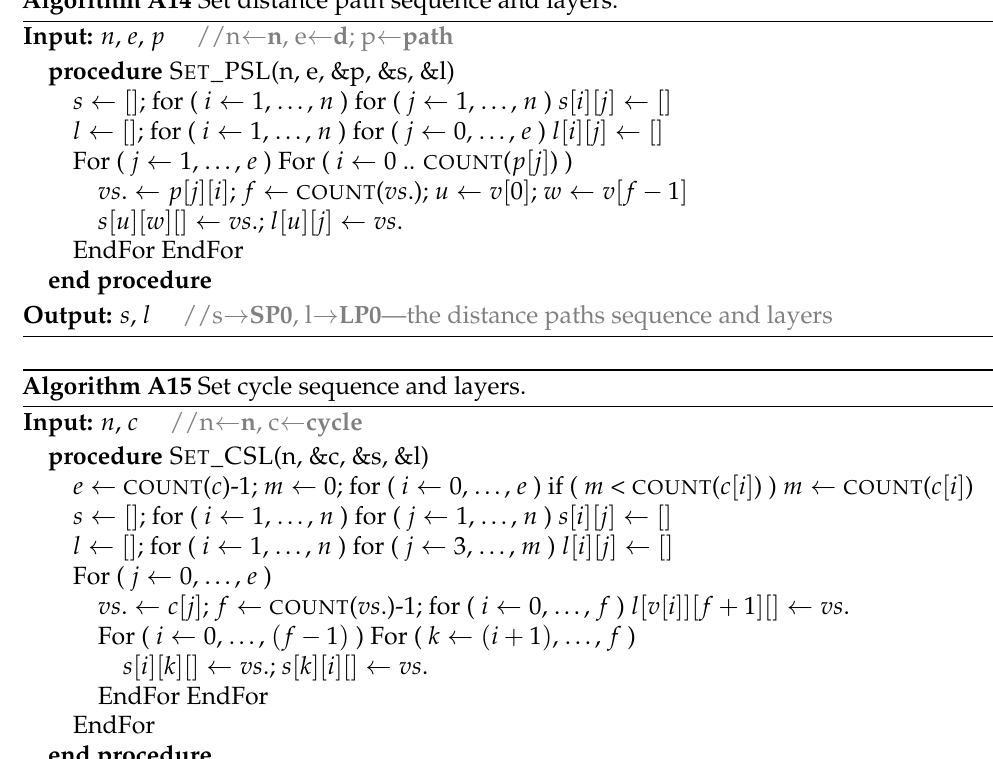
Algorithm A14 Set distance path sequence and layers.